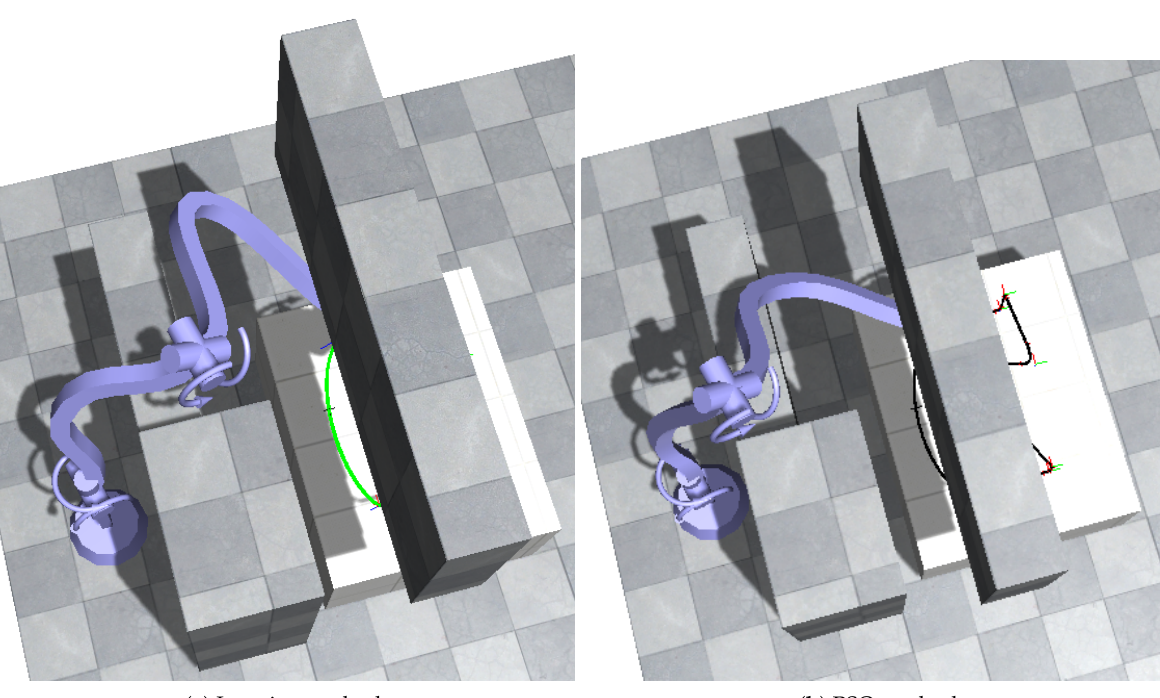
Figure 11. Graphs for the first testing workplace. ( a ) Modifications made to the robot structure in individual iteration steps during the optimization algorithm (the sums of arm lengths and individual lower and upper arm bending amounts are shown). ( b ) Selected parameters of the best particle with the particle swarm optimization (PSO) algorithm (the lower and upper arm lengths and bending amounts and the fitness function value are shown).